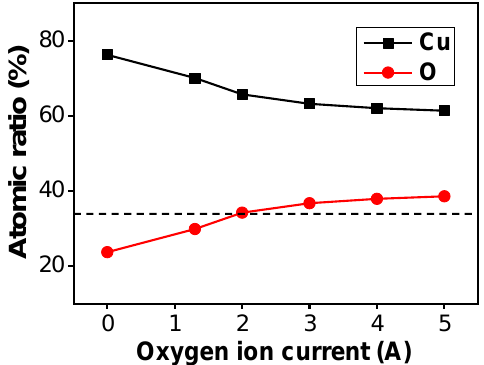
Figure 1. The atomic ratio of Cu 2 O films deposited with various oxygen ion beam current.